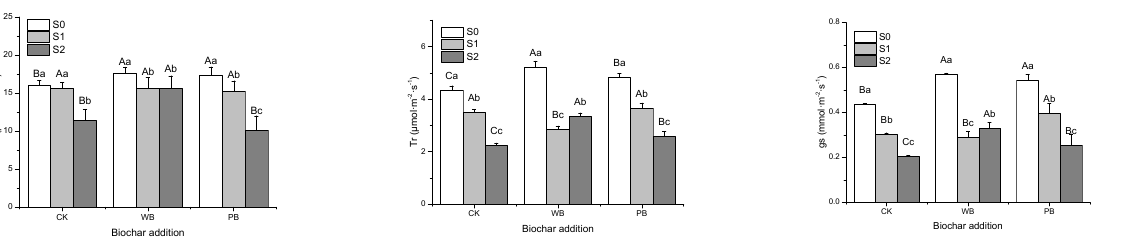
Note: * and ** indicate significance levels at p < 0.05 and p < 0.01; ns indicates there is no signifi- cantly effect at p < 0.05.